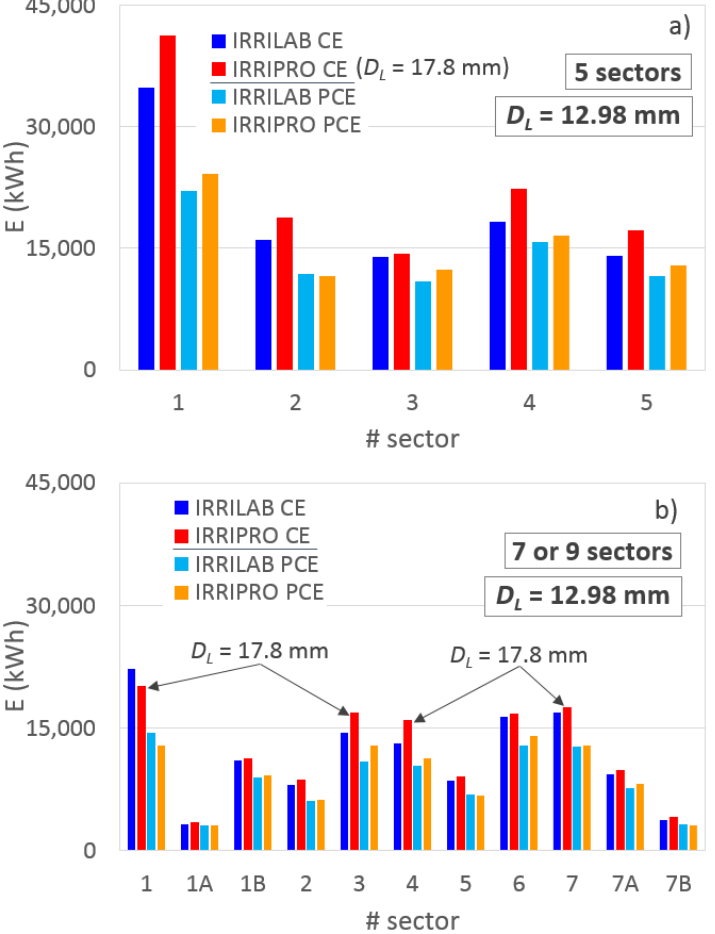
Figure 9. Comparison between the energy required by the micro-irrigation sectors with the parameters designed by IR- RILAB and with those designed by IRRIPRO, by using common emitters (CE) and pressure compensating emitters (PCE), ( a ) for the actual five sectors, and ( b ) for the seven and nine